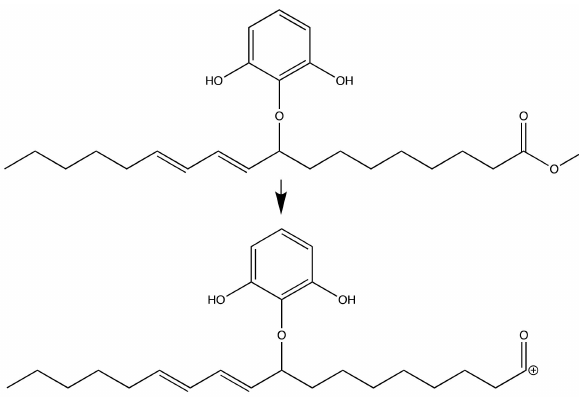
Figure 7. Fragmentation for methyl (10 E ,12 E )-